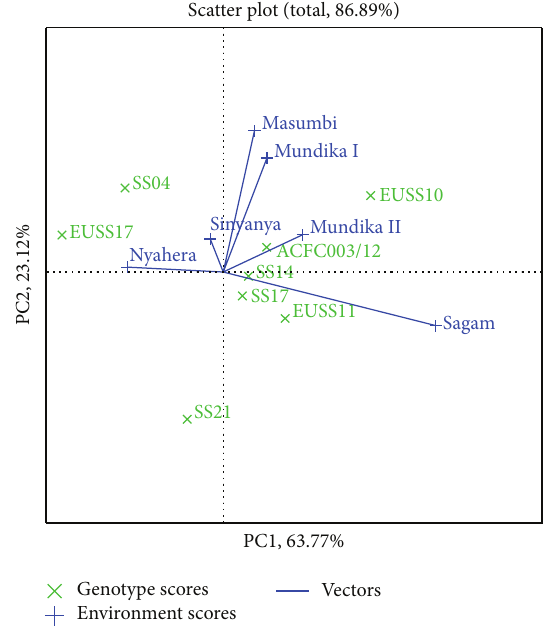
Figure 6: The biplot showing relationship between testers and mega environments for cane